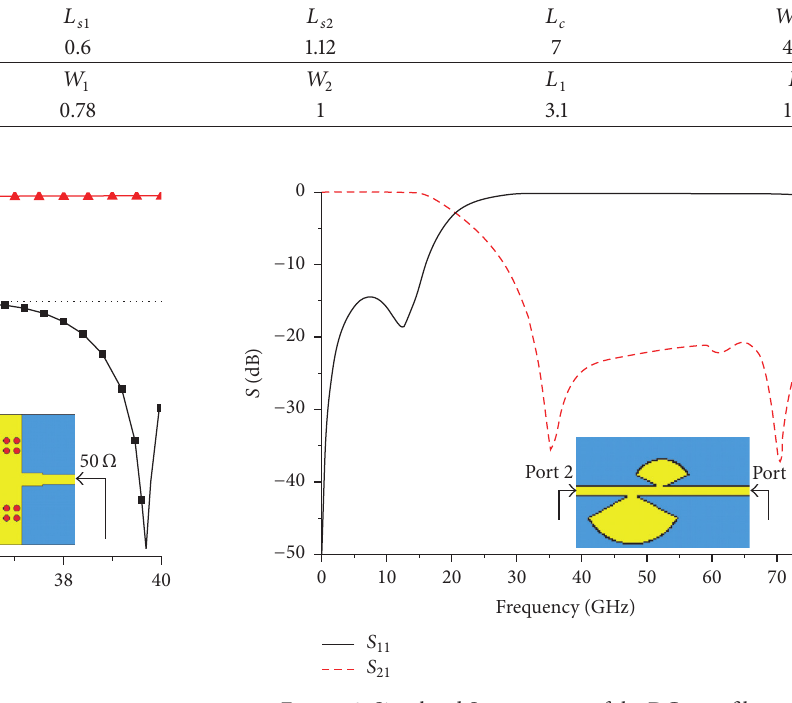
Figure2:Simulated 𝑆 -parametersofthemicrostrip-SIW-microstrip transition.